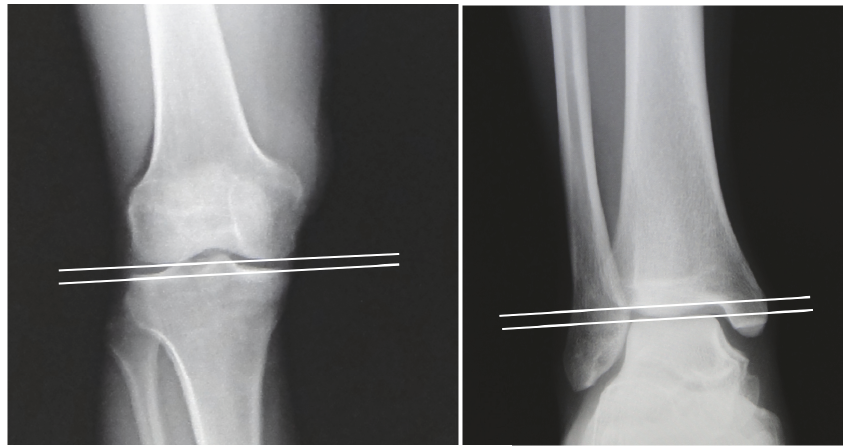
Figure 3: Joint line convergence angle (JLCA) for knee and ankle.